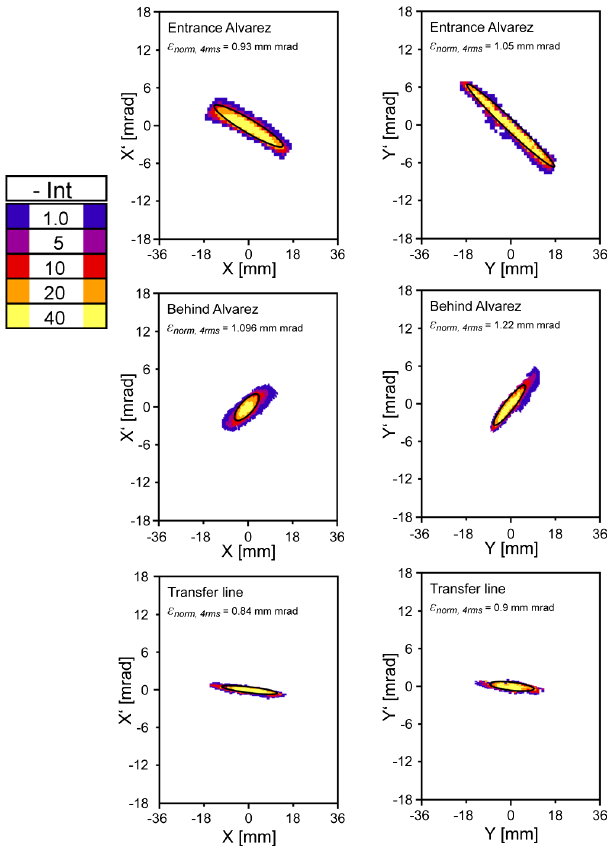
FIG. 1. High- current (2 mA) proton beam emittance measure- ments at GSI-UNILAC and transfer line to the SIS18 [1] using a standard slit-grid measurement device.